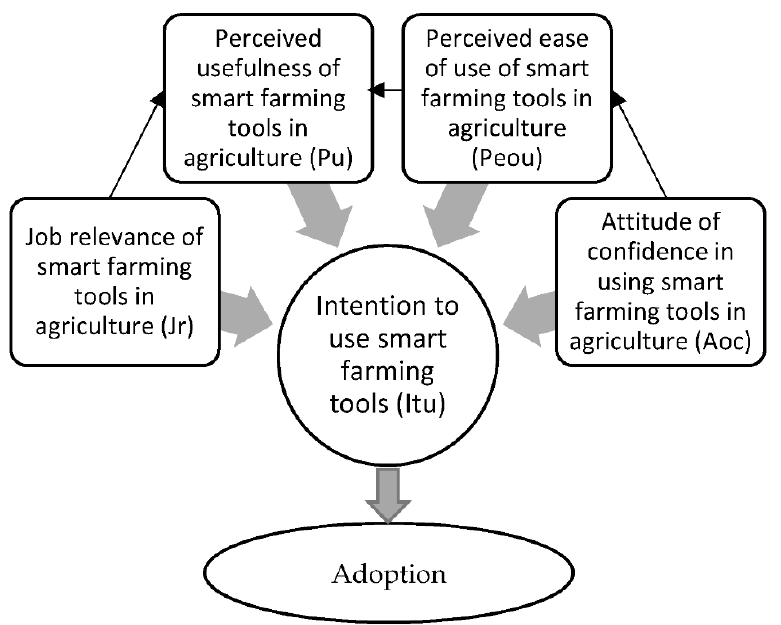
Figure 1. Scheme of the extended TAM for the adoption of PA technologies.